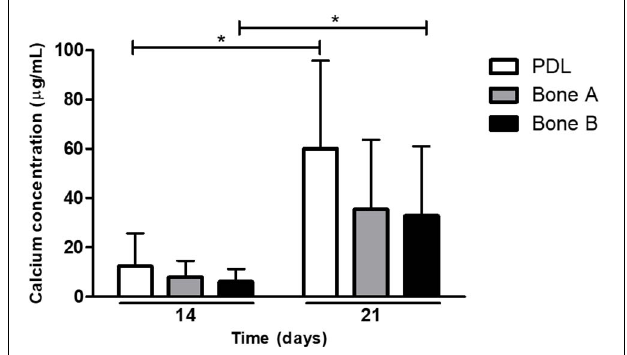
FIGURE 5 | Calcium deposits by PDL, bone A and bone B at day 14 and 21. Calcium concentration of PDL and bone B were significantly higher at day 21 compared to day 14. No significant differences were found between the three cell cultures at day 14 or day 21 (Friedman test with Dunn’s multiple comparison post hoc test). Means ± SD are shown ( n = 5). * p < 0.05 (Wilcoxon signed rank test).